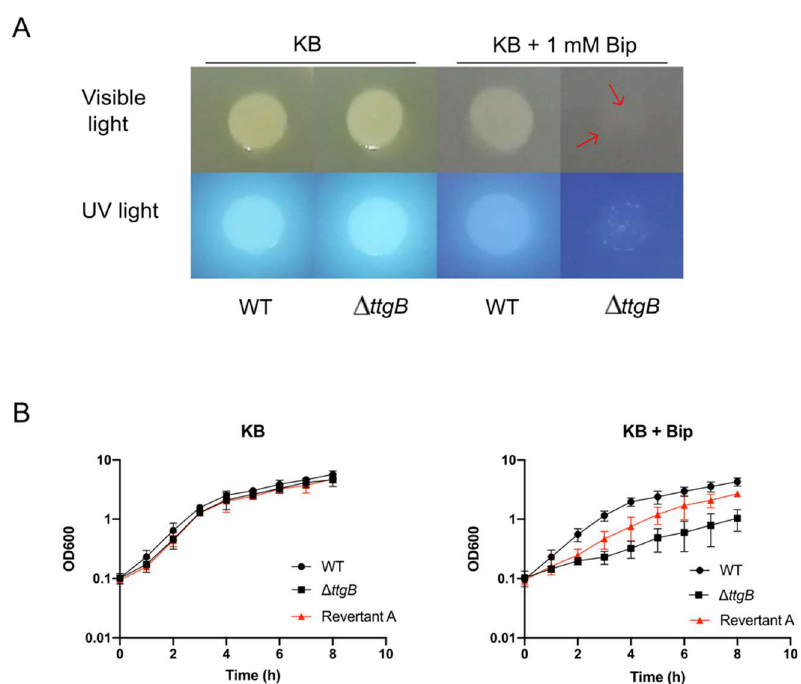
Figure 1. Second site mutation rescues growth of ∆ ttgB strain in presence of Bip. ( A ). Overnight cultures were spotted onto King’s Broth (KB) agar plates with or without supplementation with 1 mM Bip and incubated at 30 ◦ C. After 24 h, pictures were taken using visible and UV light. The red arrows indicate the position of some of the revertant colonies that are better visible in UV light. ( B ) Growth curves of wild type, ∆ ttgB and Revertant A strain (red) were performed in KB and KB plus 0.5 mM Bip for 8 h at 30 ◦ C and continuous shaking (180 rpm). One ml of culture was taken and used to record its OD 600 every 60 min. Experiments were performed a minimum of three times.